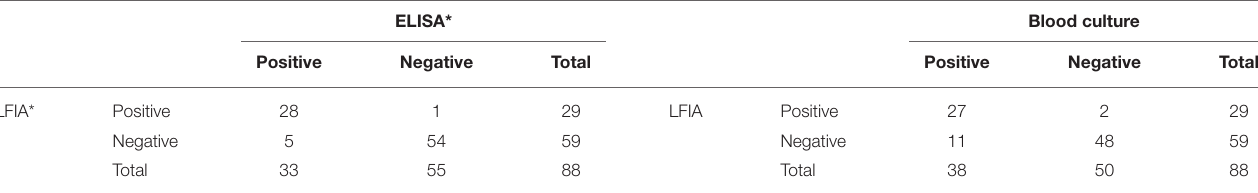
TABLE 3 | Results of Eno antibody detection and clinical blood sample culture. ELISA* Blood